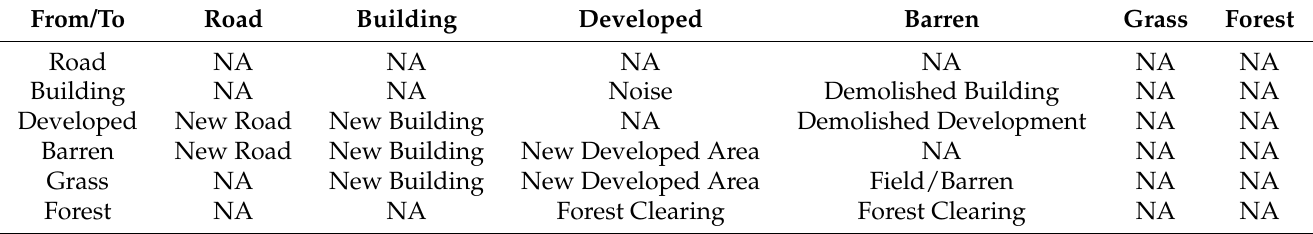
Table A1. Priority Context Table: Land cover transitions listed as NA were land cover transitions types labeled as